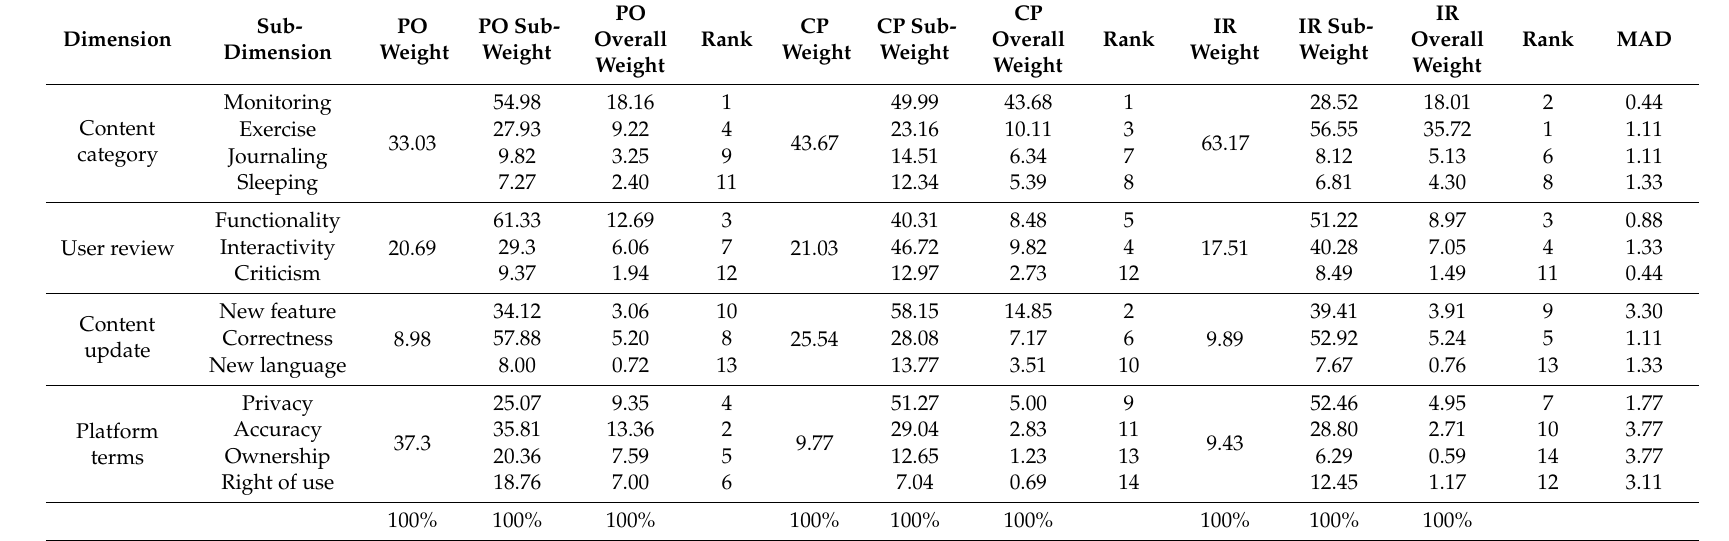
Table 4. Three Types of Panel Members